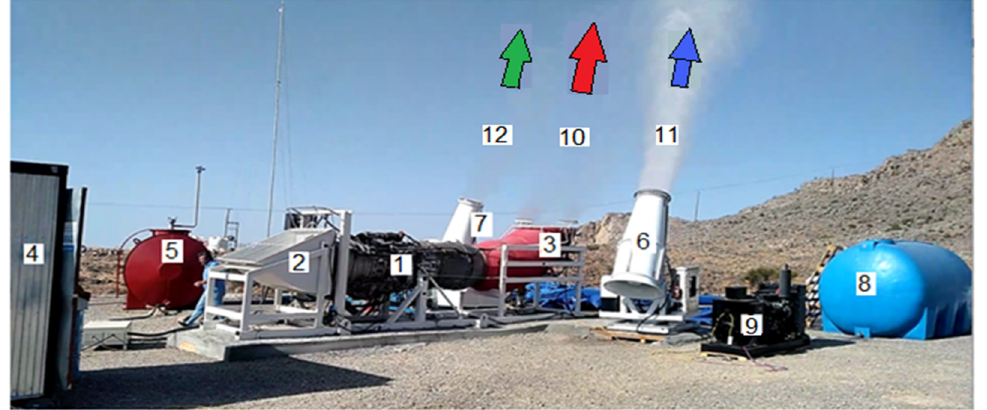
Figure 1. Experimental equipment: 1 —turbojet aircraft engine D-30; 2 —engine air intake unit; 3 —unit for the output jet vertical direction; 4 —engine start and control system; 5 —jet fuel tank; 6 —fog cannon JY-60; 7 —fog cannon WP-60; 8 —water solution tank for dissolved hygroscopic substances; 9 —diesel generator 3 × 380 V 50 kW, feeding fog cannon JY-60; 10 —high-temperature high-speed